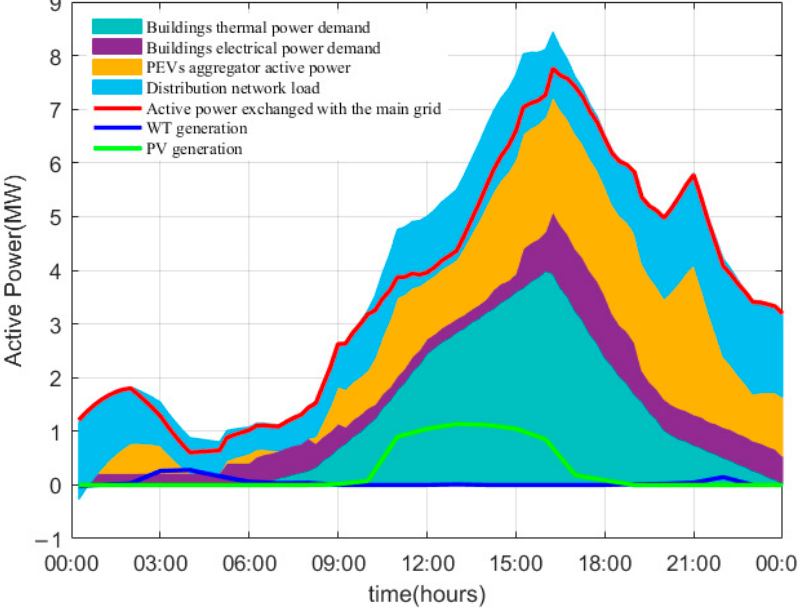
Figure 17. Buildings and PEVs’ total power demand, ADN load, RES generation, and main grid power.